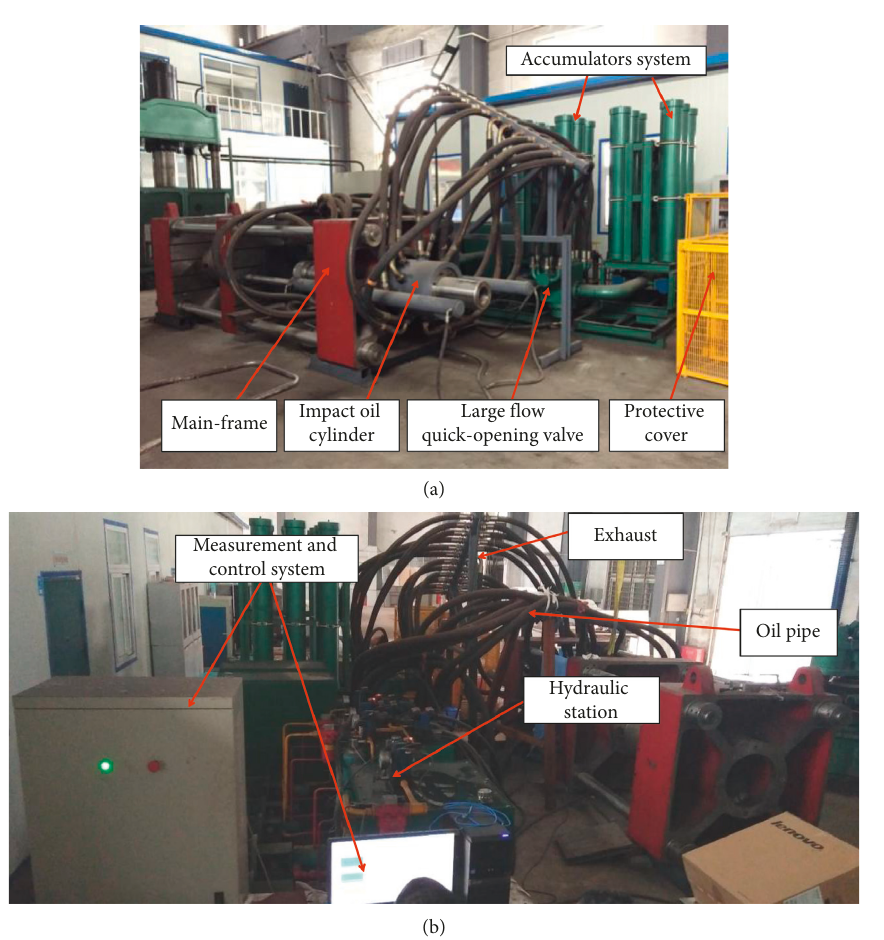
Figure 9: Impact test machine. (a) General drawing of test machine 1. (b) General drawing of test machine